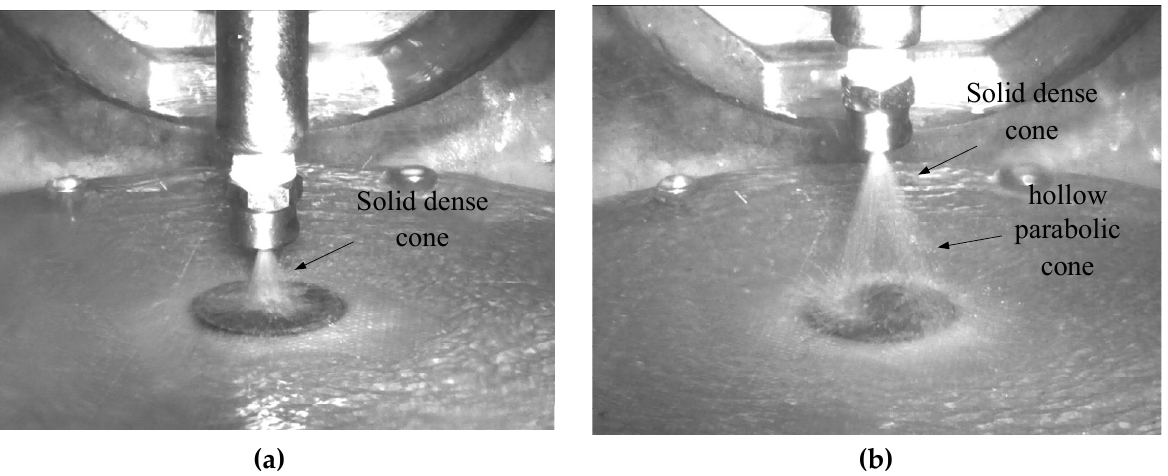
Figure 16. Visualization images of spray cone shape: ( a ) solid dense cone, coverage 16%; ( b ) solid dense cone and hollow parabolic cone.